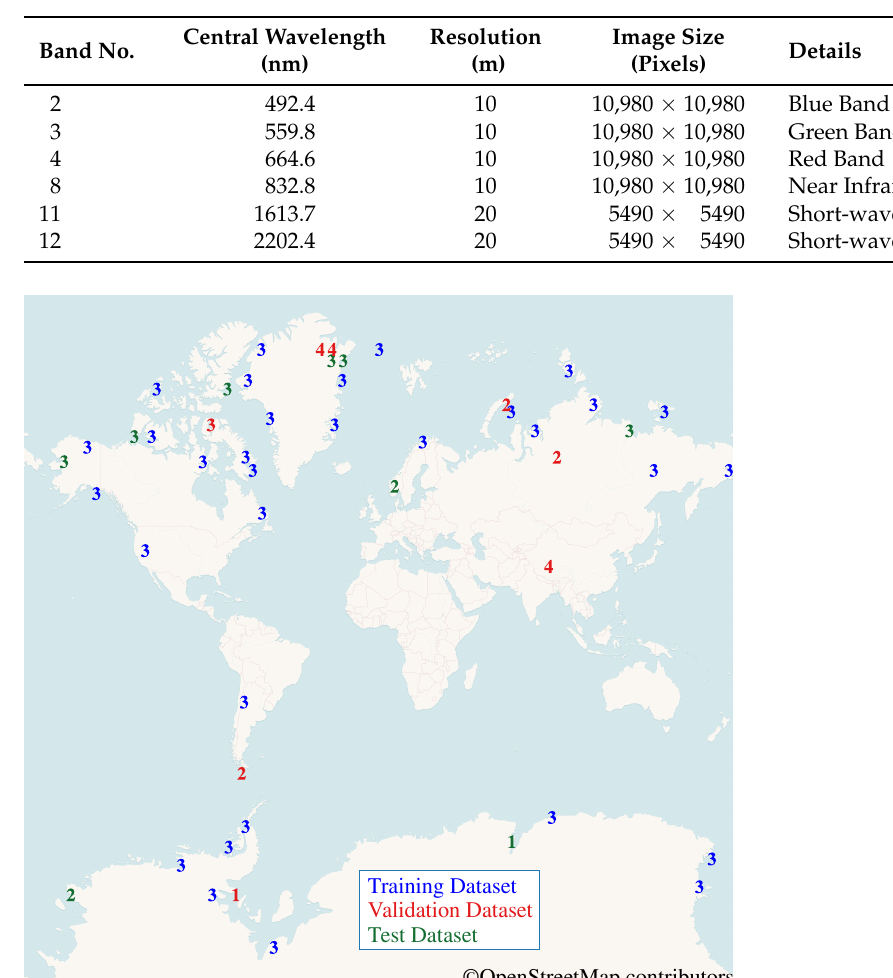
Figure 1. Geographic distribution of the datasets. The labeled numbers indicate the number of Sentinel-2 scenes used from a given site, and their colors indicate the dataset to which they belong. The six classes that we used in our model: No-Data , Clear-Sky Land , Cloud , Shadow , Snow and Water , were the same class labels as were used in the segmentation output of the F-Mask algorithm. The No-Data class was used to indicate pixels in the image that were saturated or defective and regions along the edge of the image where sensor data was not available. Such pixels can be identified using the quality indicator information provided along with the Sentinel-2 imagery. Hence, we did not include this class in the labeled dataset. The Clear-Sky Land class was used for snow- and cloud-free land, which was usually rocky surfaces in the sites used for this study. The Shadow class was used for all types of shadow, irrespective of the object that cast the shadow, or the underlying surface on which the shadow fell. The samples in the validation set were selected so that